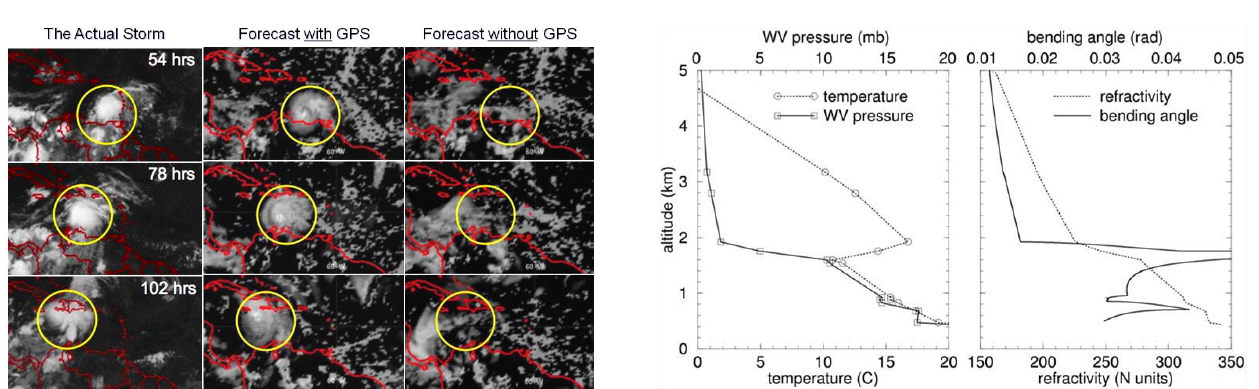
Fig. 22. Forecasts of tropical cyclone Ernesto (2006) using the NCAR WRF (Weather Research and Forecast) model. Images on the left are actual satellite photos of the event. Images on the right were generated from a forecast made without RO data, while the images in the center are from a forecast that assimilated 15 RO profiles. The elapsed time since the beginning of the forecast is shown on the left-hand images – in this case, 54, 78 and 102h (Liu et al., 2011).